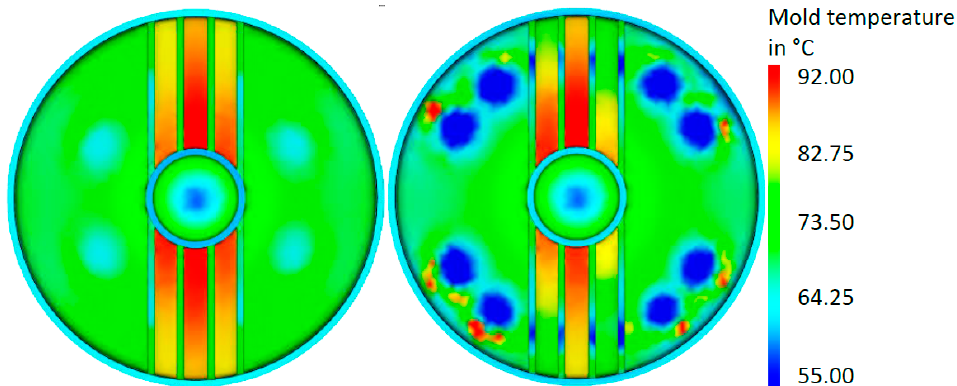
Figure 12. Temperature distribution on the lower surface of the cavity: initial configuration ( left ), optimized configuration ( right ).